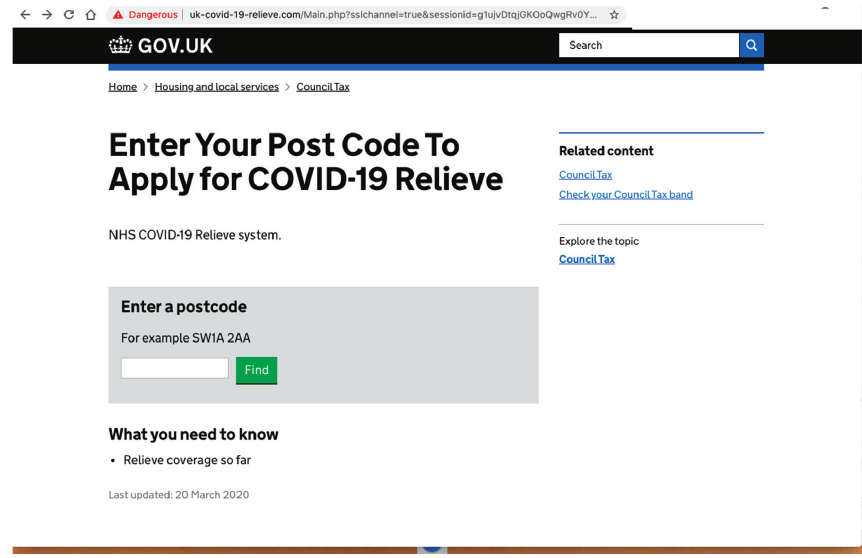
Figure 10: UK government-themed phishing page [47].